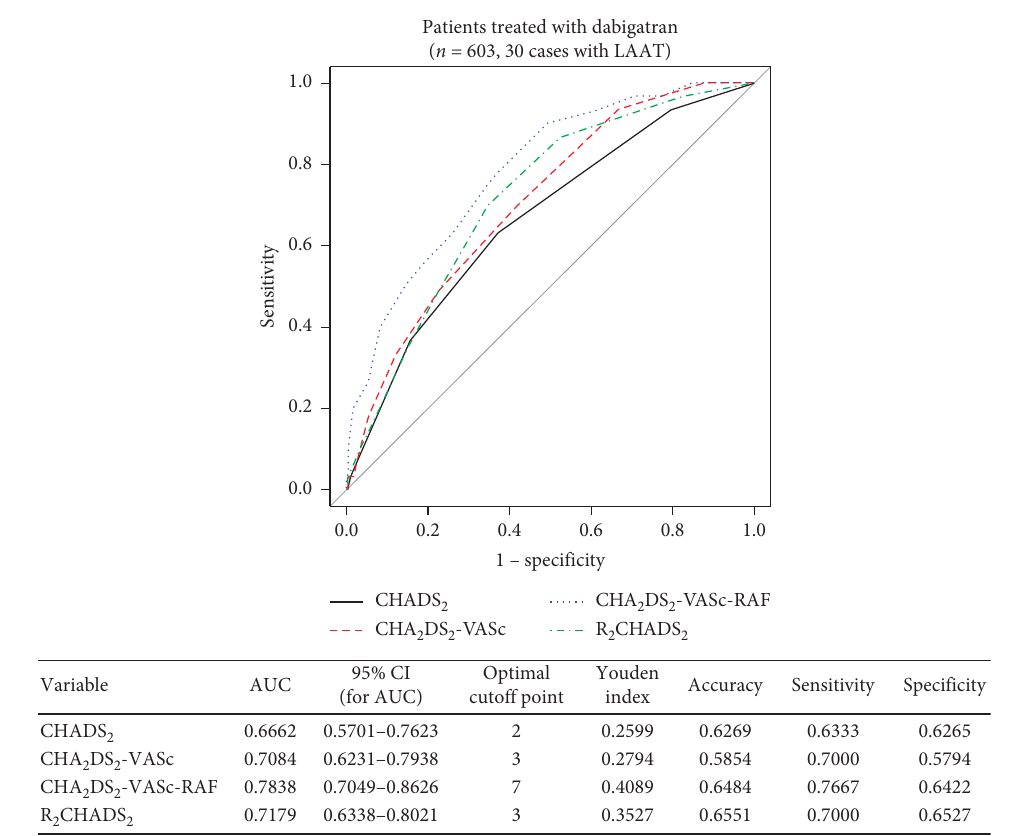
Figure 1: Receiver operating curves of CHADS 2 , CHA 2 DS 2 -VASc, CHA 2 DS 2 -VASc-RAF, and R 2 CHADS 2 for predicting LAAT and associated characteristics of that prediction in the dabigatran treatment